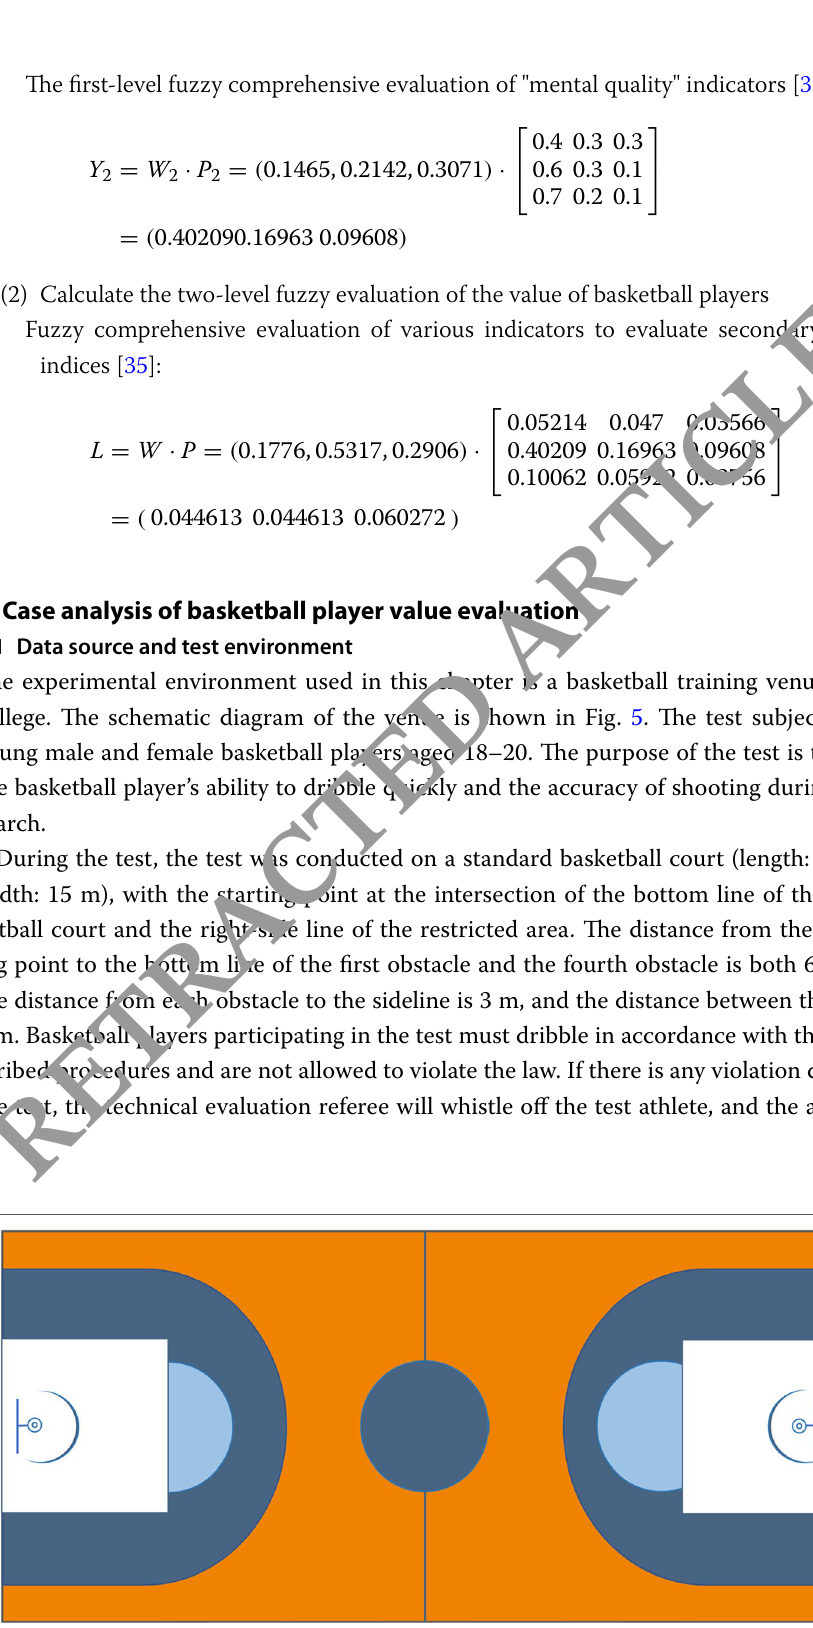
Fig. 5 Schematic diagram of the basketball player test